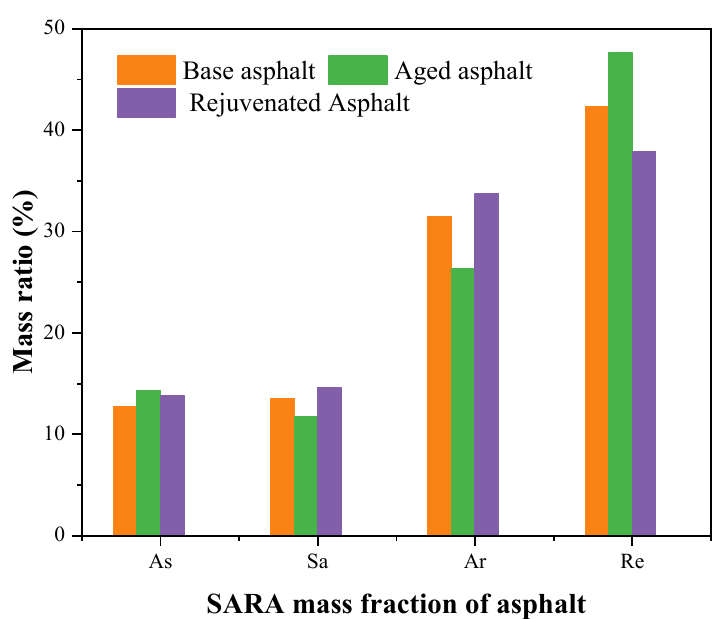
Figure 8. The result of SARA.